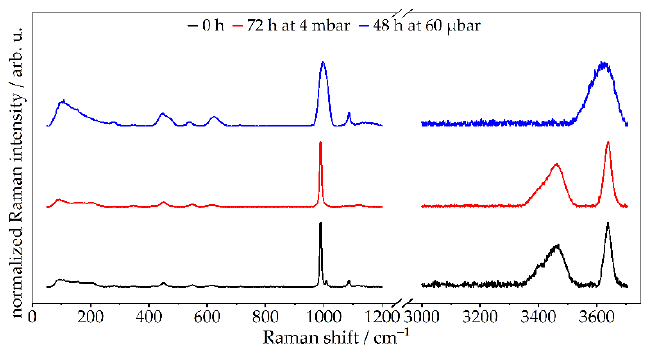
Figure 5. Raman spectra of pristine synthetic ettringite and treated ettringite after treatment at two different levels of low pressure (4 mbar for 72 h and 60 µbar for 48 h).